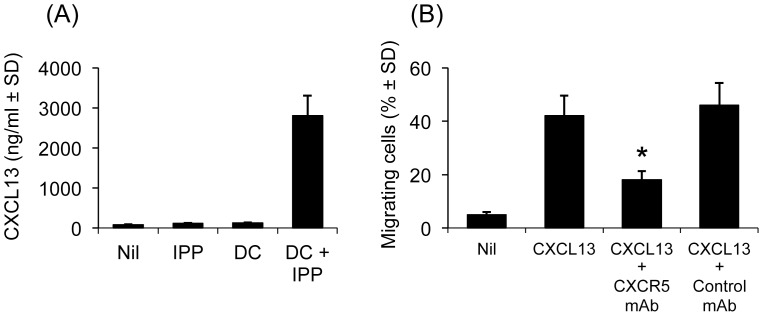
Production of CXCL13 and migration to CXCL13 Vγ9Vδ2 TFH cells.Vγ9Vδ2 TFH cells were obtained upon culture with antigen and IL-21, as previously described. In (A), Vγ9Vδ2 TFH cells were sorted and re-stimulated in vitro with IPP in the presence of irradiated DCs. Supernatants were collected after 24 hrs stimulation and CXCL13 levels assessed by ELISA. In (B) Vγ9Vδ2 TFH cells were tested for in vitro migration to CXCL13 (3 µM, final concentration) in the absence or presence of anti-CXCR5 or isotype-matched control mAbs (15 µg/ml, final concentration). Data are representative of three independent experiments. *p<0.02 when compared with groups consisting of Vγ9Vδ2 TFH cells migrating to CXCL13 in the absence of any Ab or in the presence of isotype-matched control mAb.